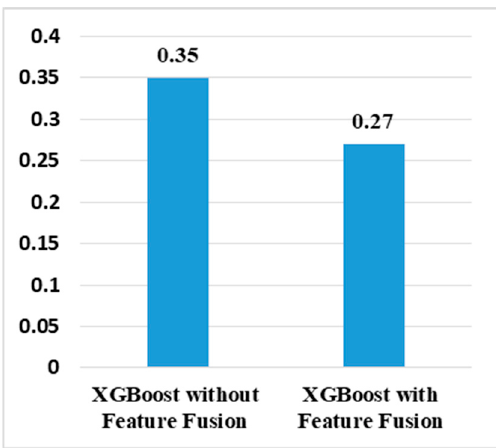
Figure 6. Summary of computational time.